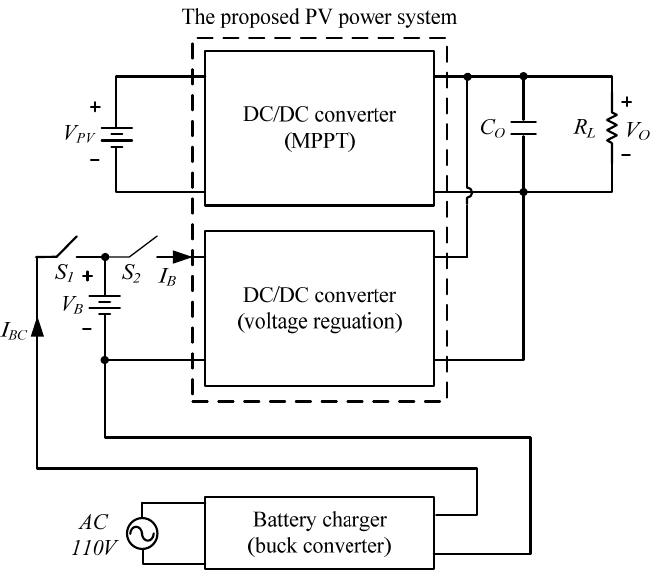
Figure 21. Block diagram of the proposed PV power system and battery charger.